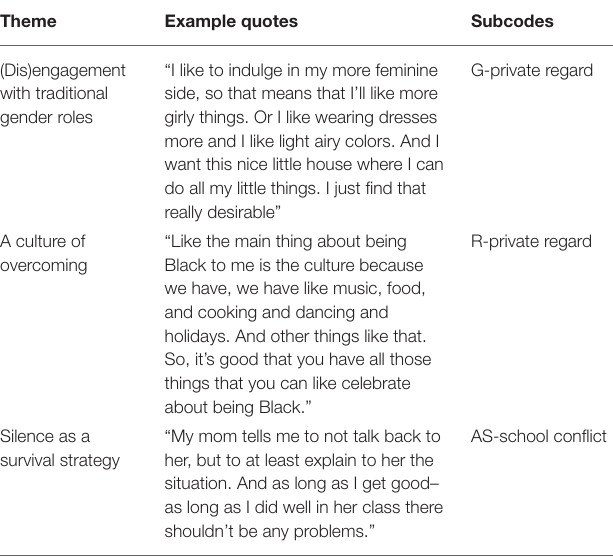
TABLE 3 | Theme, example quotes, and subcodes for research question